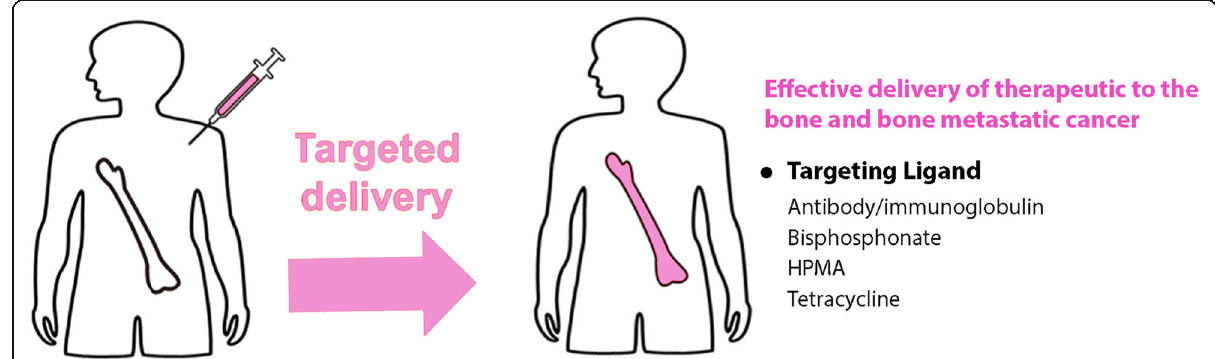
Fig. 2 Targeted delivery of drug and nanoparticles to OS by conjugating ligands and polymers (such as antibodies, BP, HPMA, and tetracycline) having high affinity towards